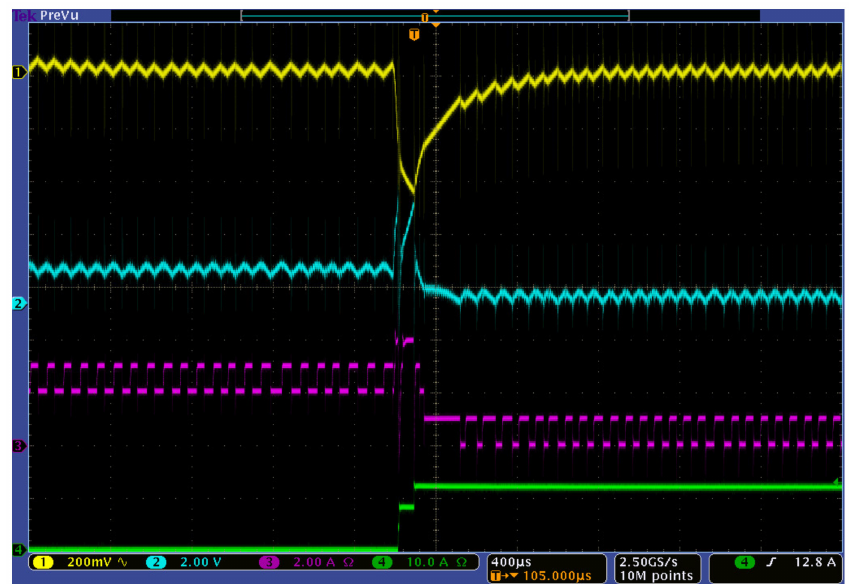
Figure 12. Experimental results (large load perturbation detail), ILoad = 2.5–12.5 A. Yellow, bus voltage ripple; blue, low-power sections control signal; pink, low-power sections bus current; green, high-power sections bus